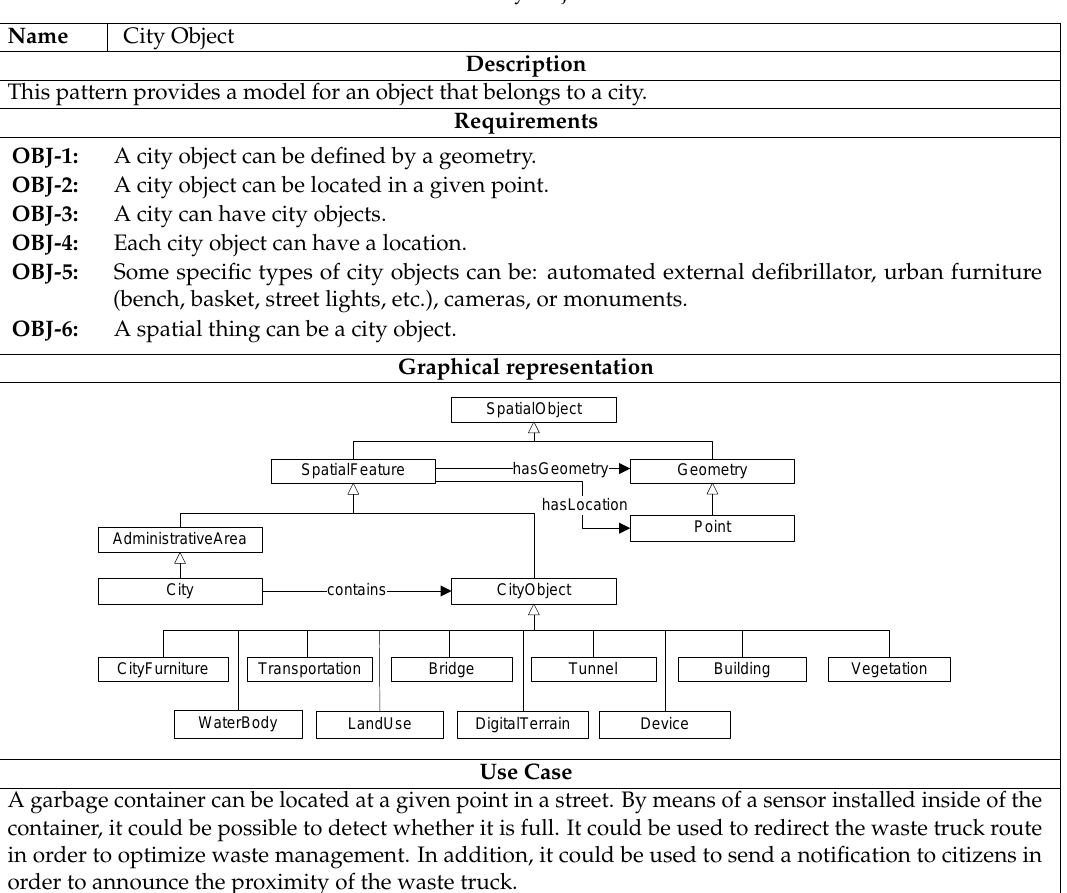
Table 8. City Object